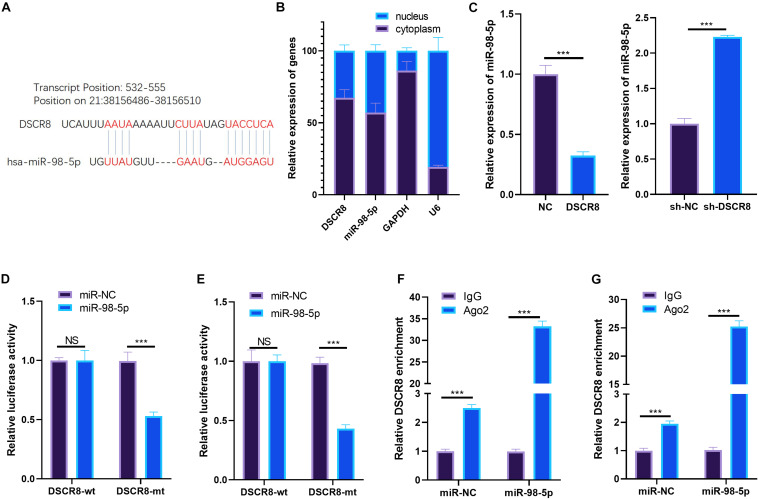
DSCR8 targeted miR-98-5p. (A) Through lncBase v.2 (http://carolina.imis.athena-innovation.gr/diana_tools/web/index.php?r=lncbasev2%2Findex), we predicted the targets of long non-coding RNA (lncRNA) DSCR8 and found that miR-98-5p is one of the targets of DSCR8. (B) RT-PCR was used to detect DSCR8 and miR-98-5p in the cytoplasm and nucleus. (C) RT-PCR was adopted for monitoring miR-98-5p, which selectively regulates DSCR8 in OC cells. (D,E) Dual luciferase reporter assay was performed to verify miR-98-5p and DSCR8 correlation. (F,G) The relationship between miR-98-5p and DSCR8 was verified by RNA immunoprecipitation (RIP) experiments. NS = P > 0.05, ***P < 0.001.